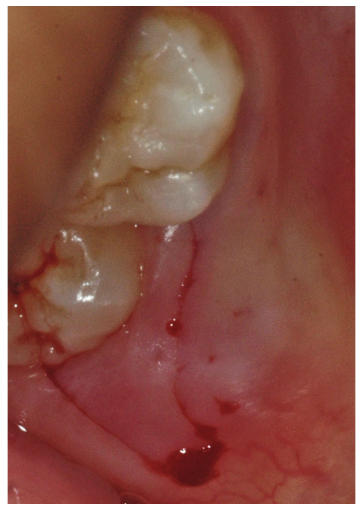
Figure 8: Incision of the tuberosity donor site.